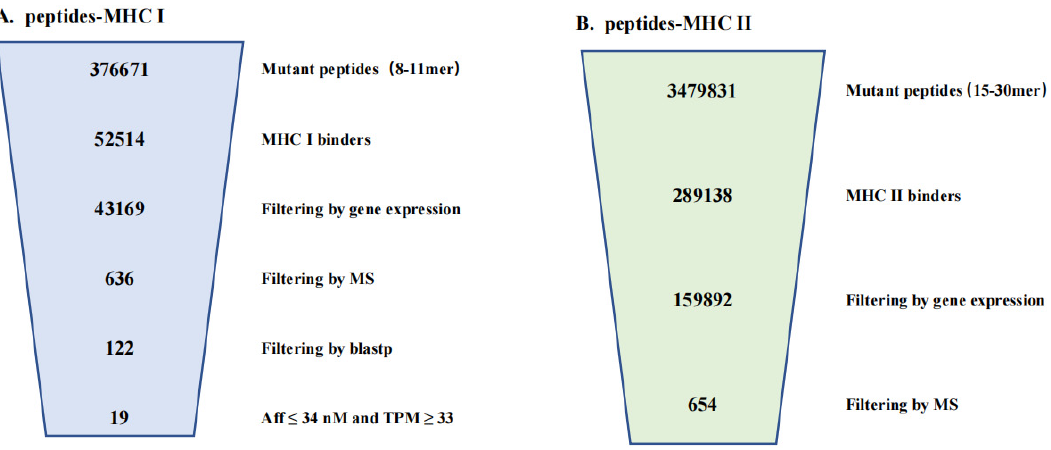
Figure 5. Results overview for the neoantigen discovery: ( A ). MHC class I binding neoantigens (8–11-mer) ( B ). MHC class II binding neoantigens (15–30-mer).